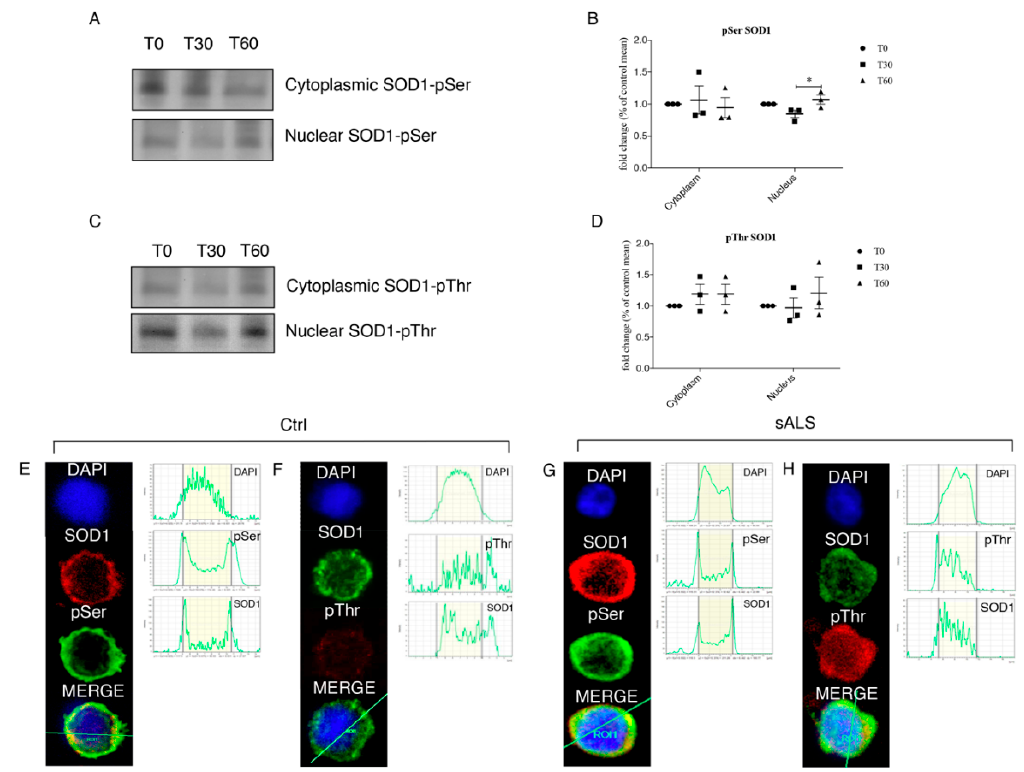
Figure 4. ( A , B ) 1 mM H 2 O 2 treatment determines significant phosphorylation at Ser residue at T60 in the nuclear compartment. SOD1 was immunoprecipitated and representative immunoblotting for pSer was reported for the nucleus. ( C , D ) 1 mM H 2 O 2 treatment induces significant phosphorylation also at Thr residue at T60 in the nuclear compartment. SOD1 was immunoprecipitated and